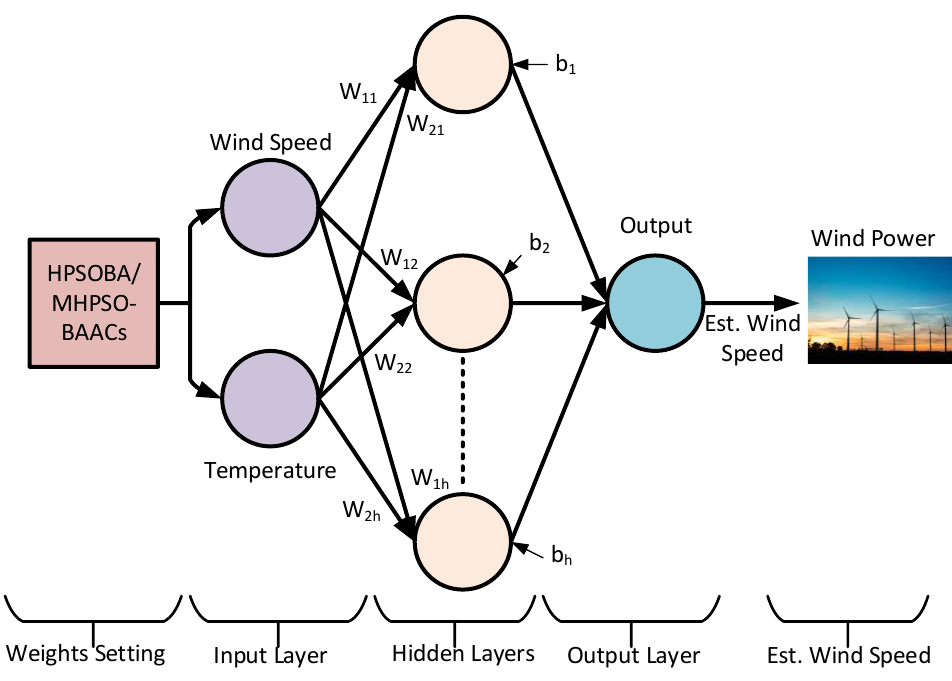
Figure 7. Block Diagram of Trained Neural Networks.